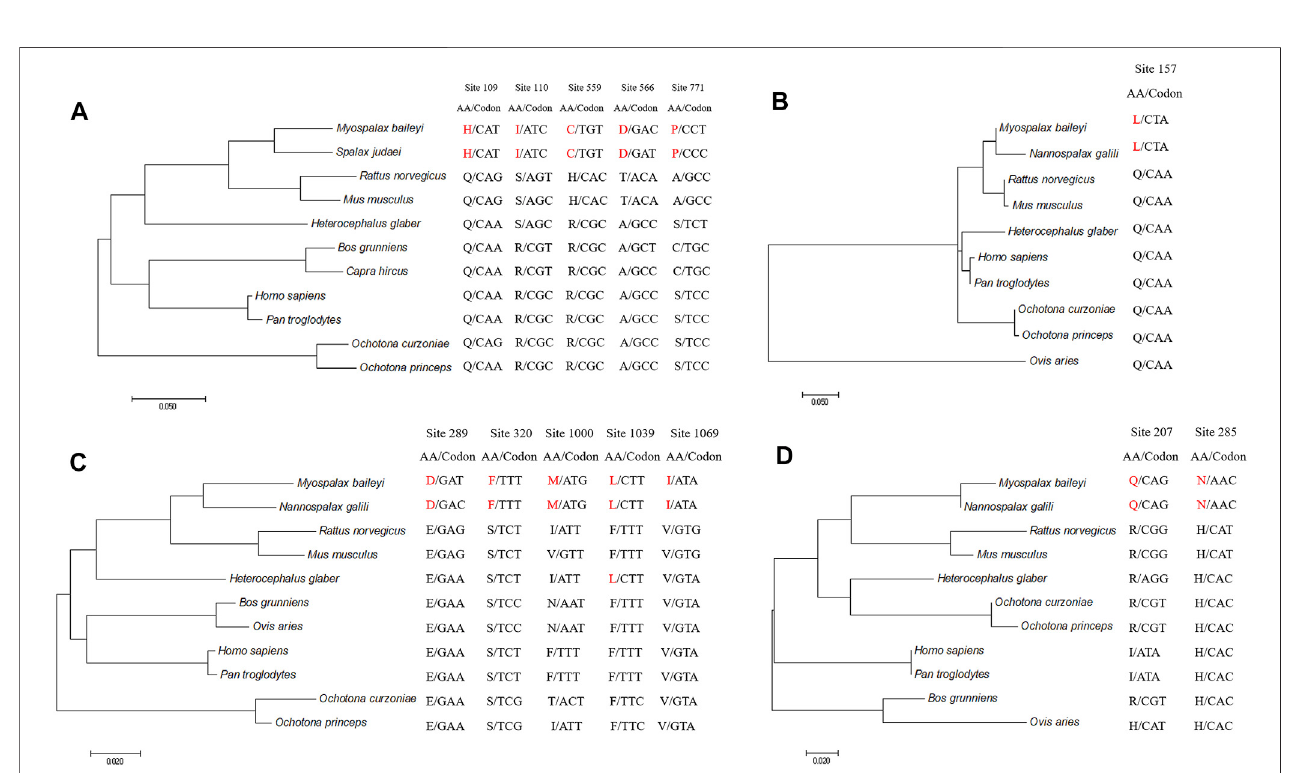
FIGURE 2 | Evolution of convergent sites in Pidd, Puma, Apaf1, and Ifbp3 sequences. Panels indicate Pidd (A) , Puma (B) , Apaf1 (C) and Igfbp3 (D) . Amino acids and codons of convergent sites are shown. Amino acids in Myospalax baileyi and Nannospalax galili are highlighted in red.